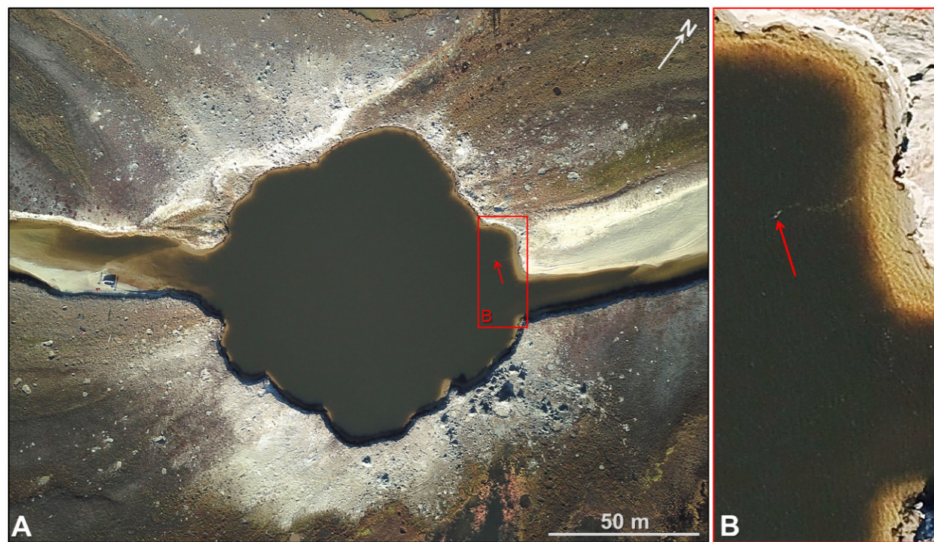
Figure 8. Aerial photograph of Seyakha Crater area captured using a UAV ( A ) with an enlarged fragment ( B ), 19 September 2018 (photo by Igor